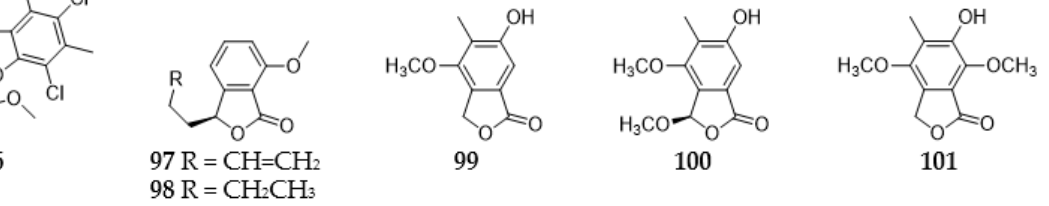
J. Fungi 2023 , 9 , x FOR PEER Figure 6. Aspergillus -derived benzofuranones ( 96 – 101 ). Figure 6. Aspergillus -derived benzofuranones ( 96 – 101 ).